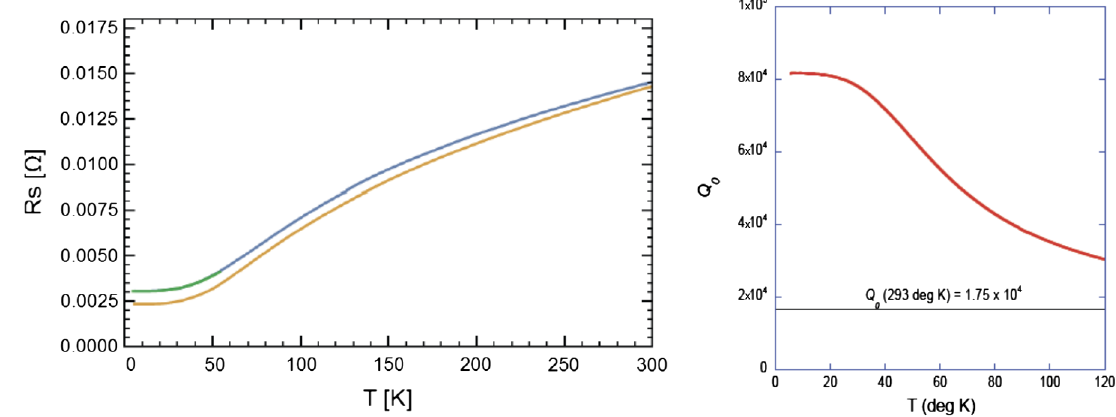
FIG. 14. (left) Radio-frequency surface resistance of both accelerating cavities, SLAC (blue) and UCLA (green). This is compared to a theoretical rf surface resistance of copper with IACS 95% and RRR ¼ 400 . (right) Quality factor in SLAC test cavity.